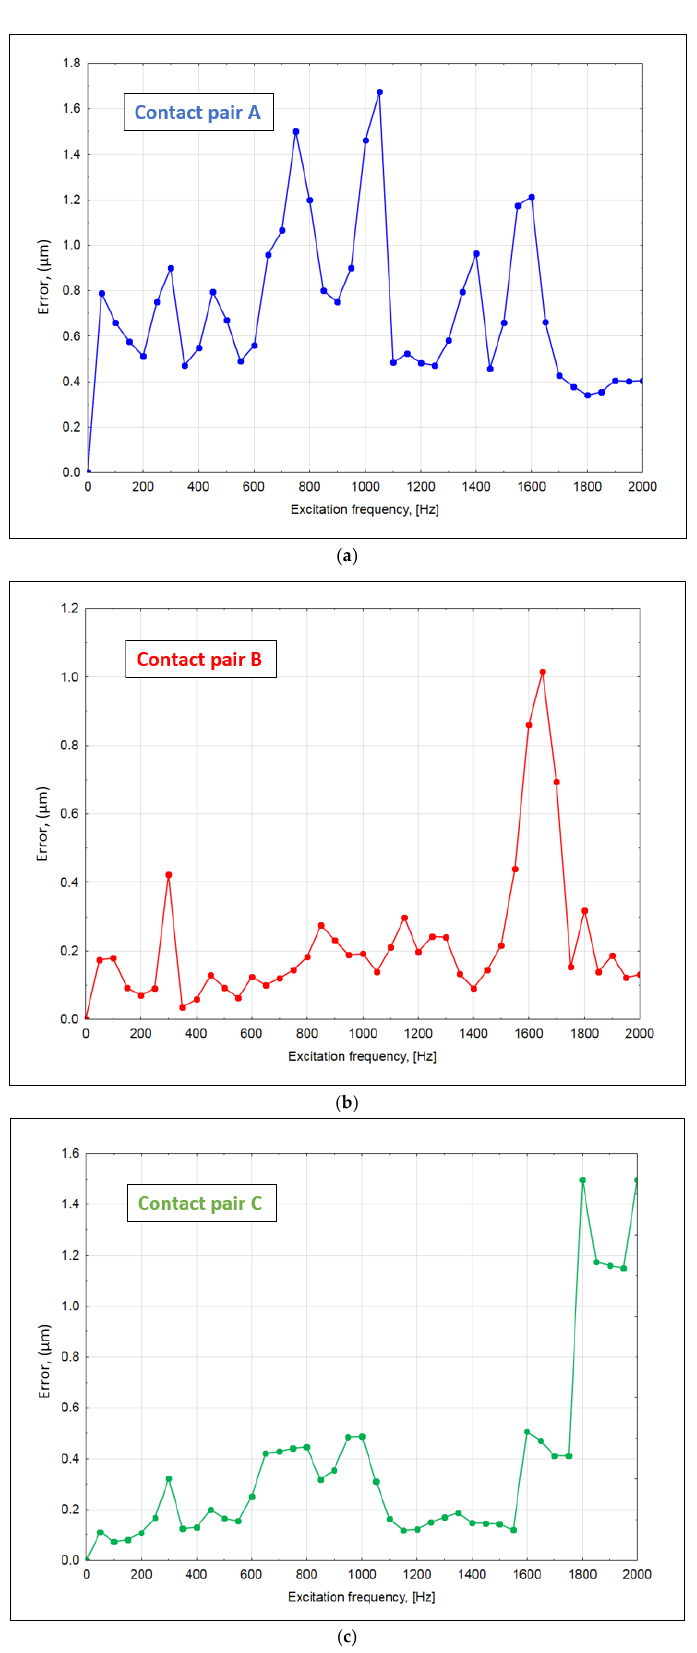
Figure 9. Encoder’s errors generated by external mechanical vibrations. ( a ) Mechanical design with contact pair A; ( b ) contact pair B; ( c ) contact pair C. Although the electrodynamic shaker excitation amplitudes were not very high, they were sufficient to distinguish the dynamic effects that have a direct impact on the quality of the displacement measurement. The reading head with contact pair A had several clear peaks distributed over the whole range of tested frequencies. The maximum error value